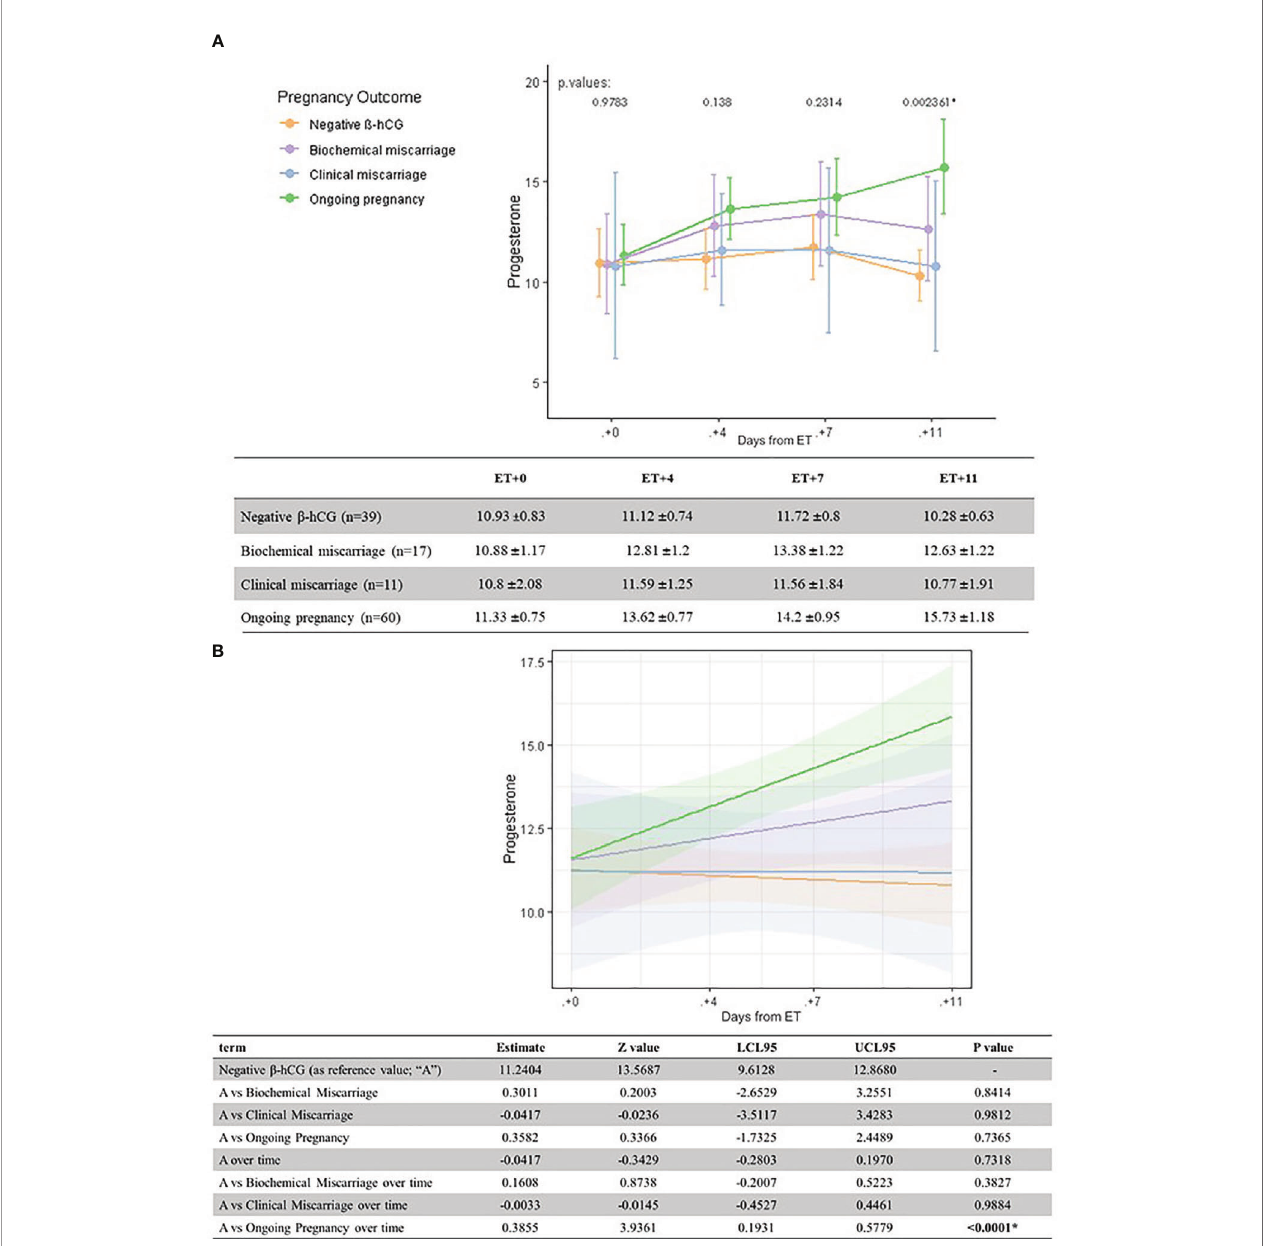
FIGURE 1 | Univariate analysis (A) and linear regression model (B) of serum P levels (ng/ml) according to pregnancy outcome and the day after